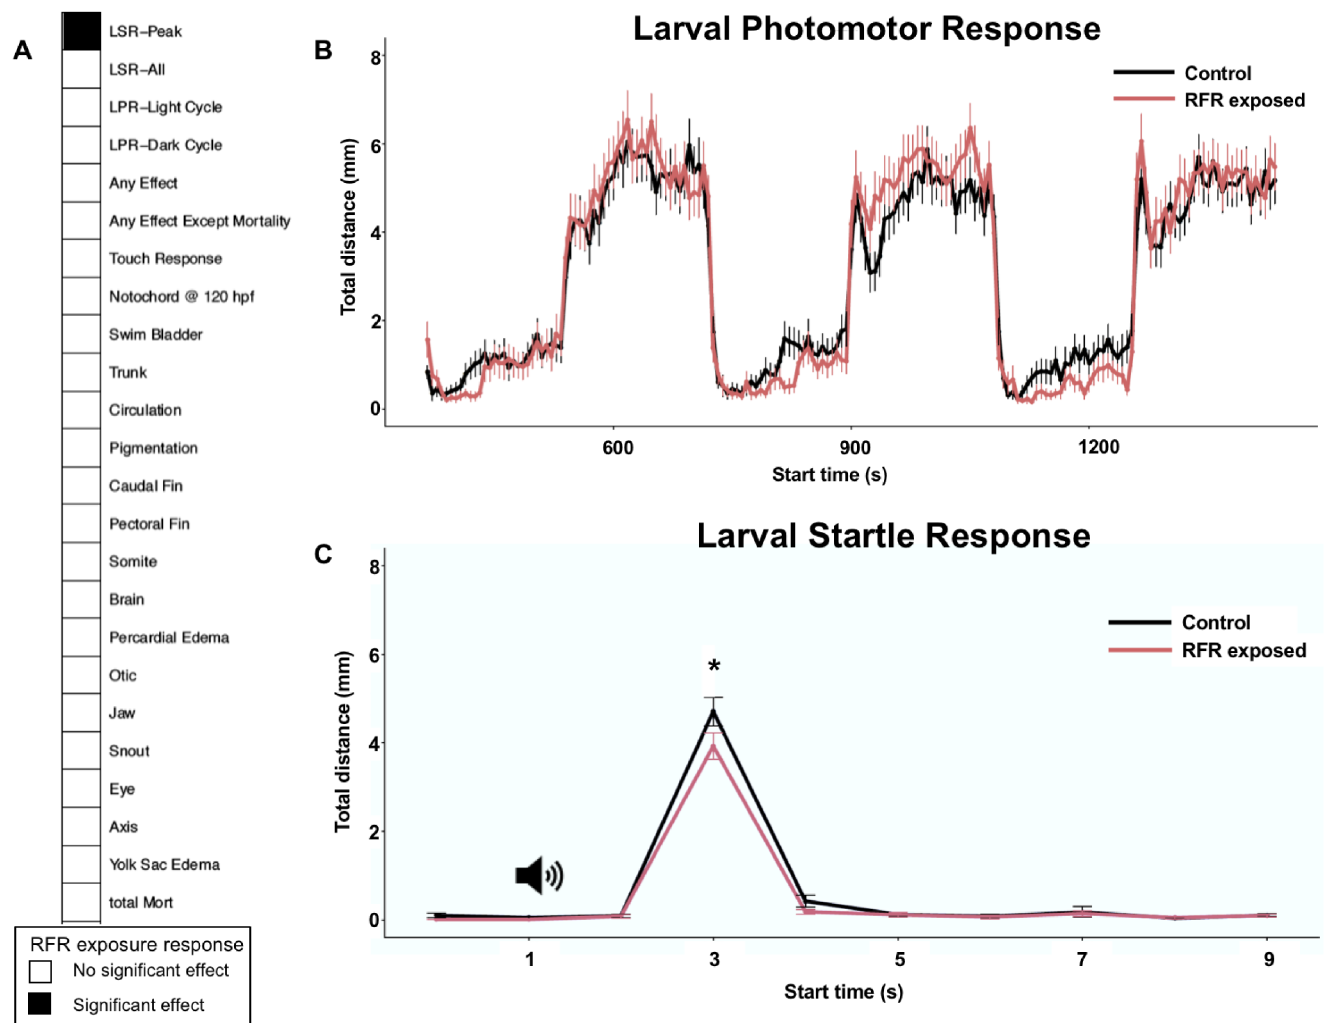
Fig 2. Effects of RFR on embryonic development. Embryos were exposed to 3.5 GHz, ~ 30 dBm RFR, at a specific absorption rate (SAR) � 8.27 W/Kg from 6–48 hpf and developmental parameters were measured at 120 hpf. All assays (panels A-C) were sequentially conducted from the same subset of embryos, with a total of 144 embryos from 3 replicate experiments used per treatment condition. (A) Summary of effects observed within our study. Measured parameters include mortality (Mort), 17 morphological parameters and 2 behavioral parameters (larval photomotor (LPR) and startle (LSR) responses). “Any effect” indicates a combination of all 17 morphological parameters. “LSR-All” indicates AUC and Peak measurements combined. (B) RFR exposure does not have any significant effect on photomotor response. (C) RFR exposure results in reduced peak height for startle response. denotes the acoustic signal. � indicates a statistically significant difference at p <